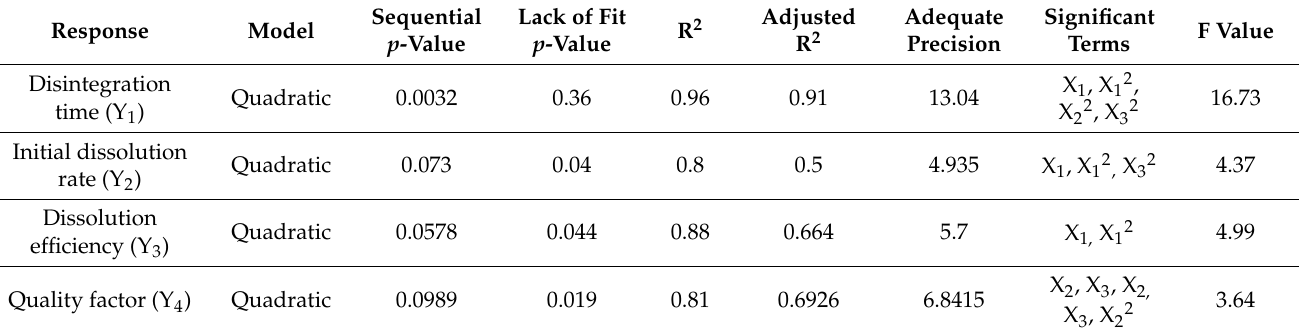
Figure 7. FLP HPLC chromatograms and calibration curve, ( A ): pure FLB; ( B ): FLB film, ( C ): FLB calibration curve. Table 4. ANOVA analysis for the selected models for different responses of